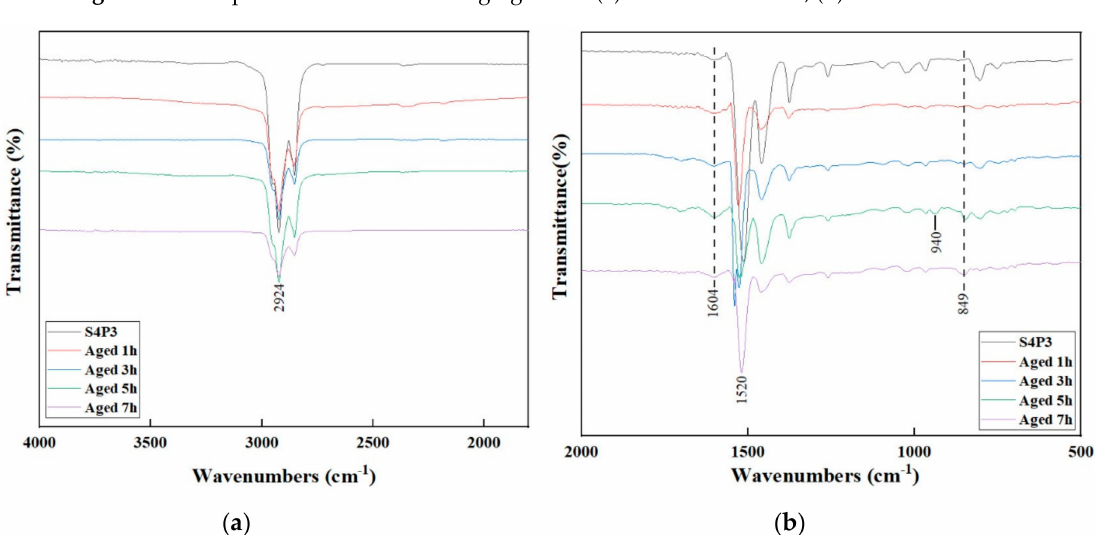
Figure 7. FTIR spectra of S4P3 at di ff erent aging times. ( a ) 4000 to 1500 cm − 1 ; ( b ) 1800 to 600 cm − 1